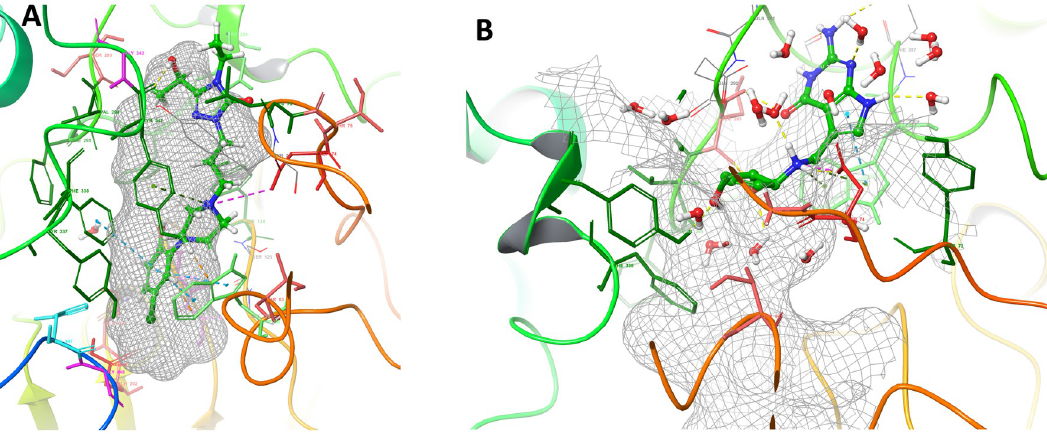
Fig 5. Final snapshots (100 ns) obtained from MD simulations: Etoperidone (A) and Queuine (B). Etoperidone stability is maintained within the binding cleft and interacts with CAS site (gray meshed surface); Queuine seems to diffuse out of the binding cleft and preserves its interactions with the PAS